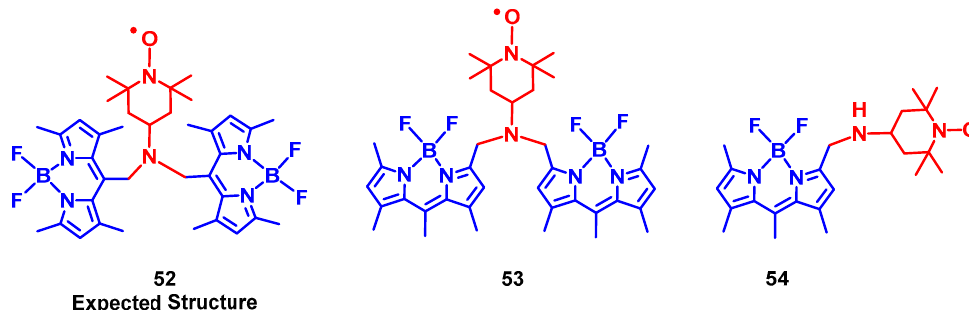
Figure 17. TEMPO-Bodipy triad 53 prepared based on an unexpected nucleophilic substitution reaction of Bodipy. 54 is a reference compound. Triad 52 is the anticipated product, base on the previously reported Bodipy derivatization chemistry. However, it was not obtained in our synthesis.